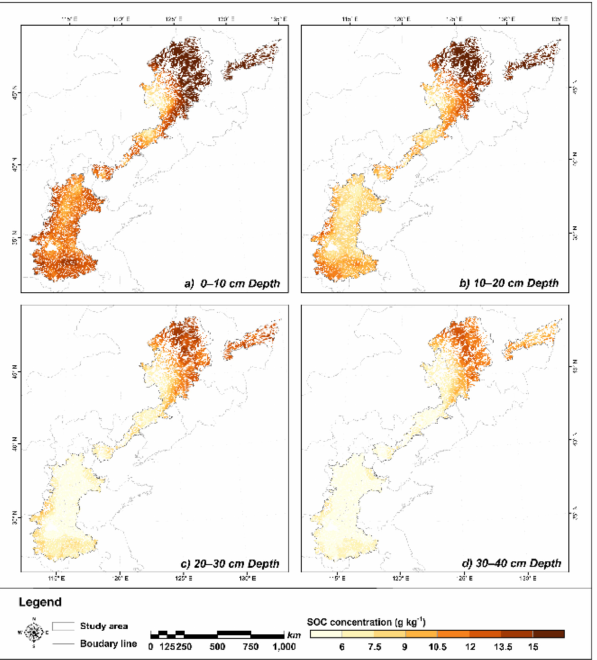
Figure 5. Spatial and vertical distribution pattern of SOC concentration with RF in ( a ) 0–10 cm depth, ( b ) 10–20 cm depth, ( c ) 20–30 cm depth and ( d ) 30–40 cm